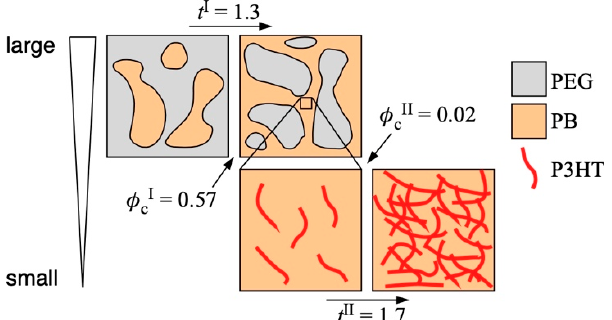
Figure 4. Schematic image of hierarchic percolations (double percolation) of the P3HT-nanofiber-filled PB/PEG blend composites.